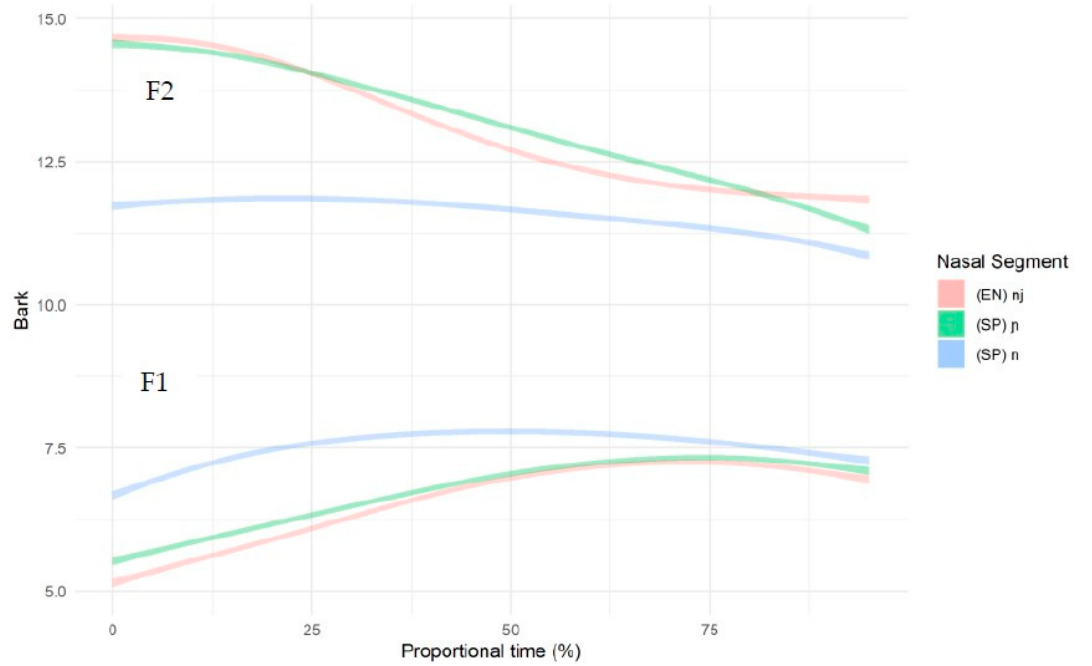
Figure 5. Smoothing Spline ANOVA of formant trajectories by nasal segment.